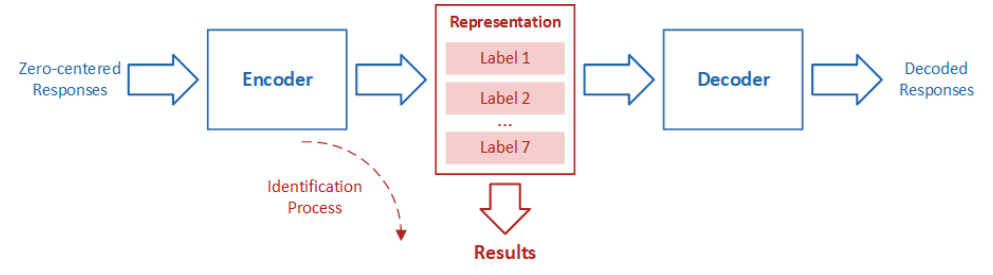
Figure 3. The basic principle of